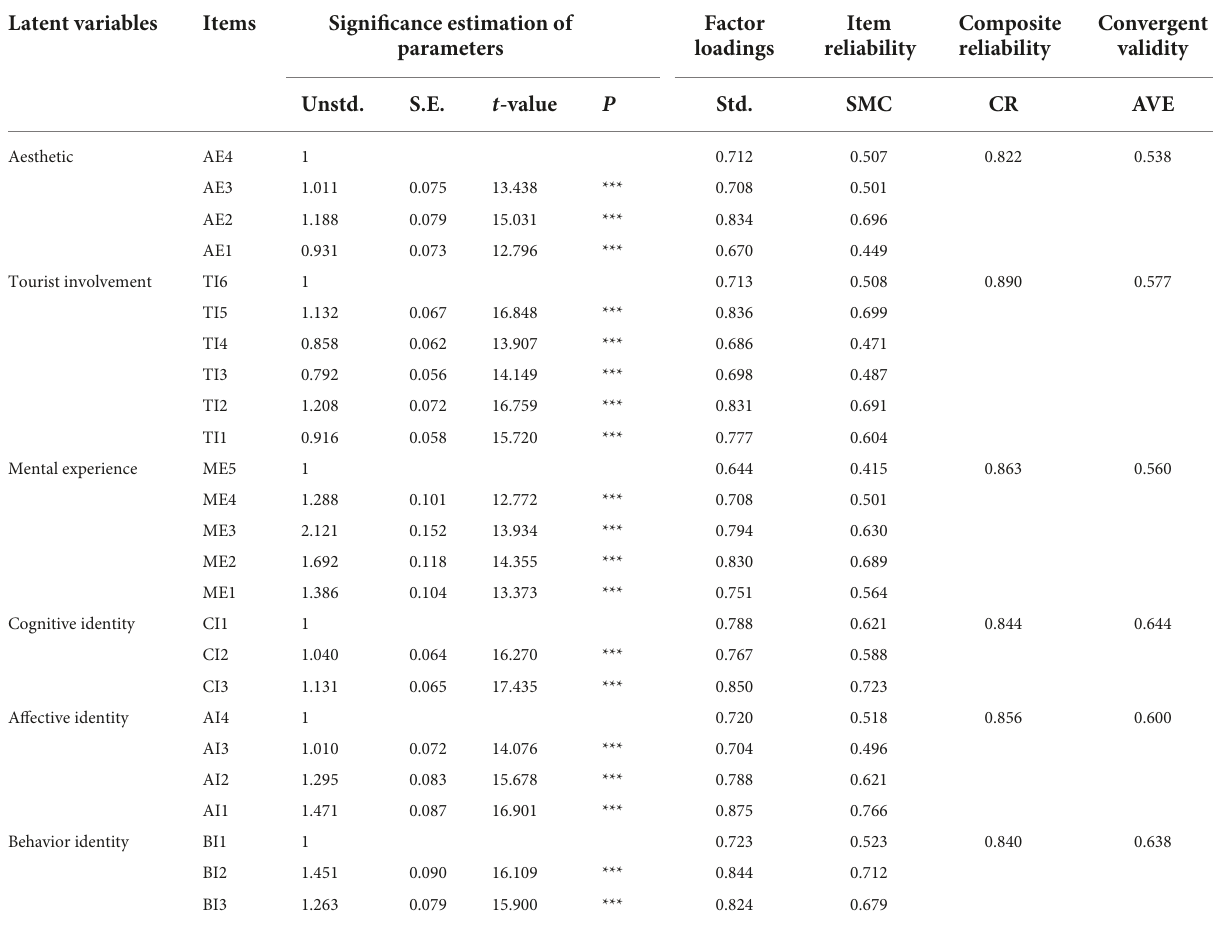
TABLE 3 Results of composite reliability and convergent